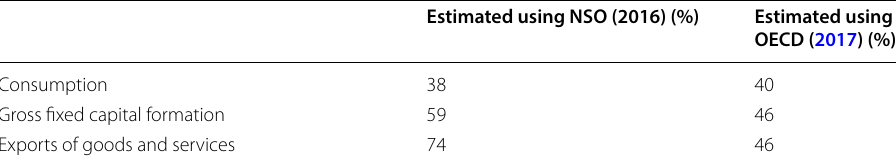
Table 1 Comparison of import content estimates for Malta’s GDP components in 2010